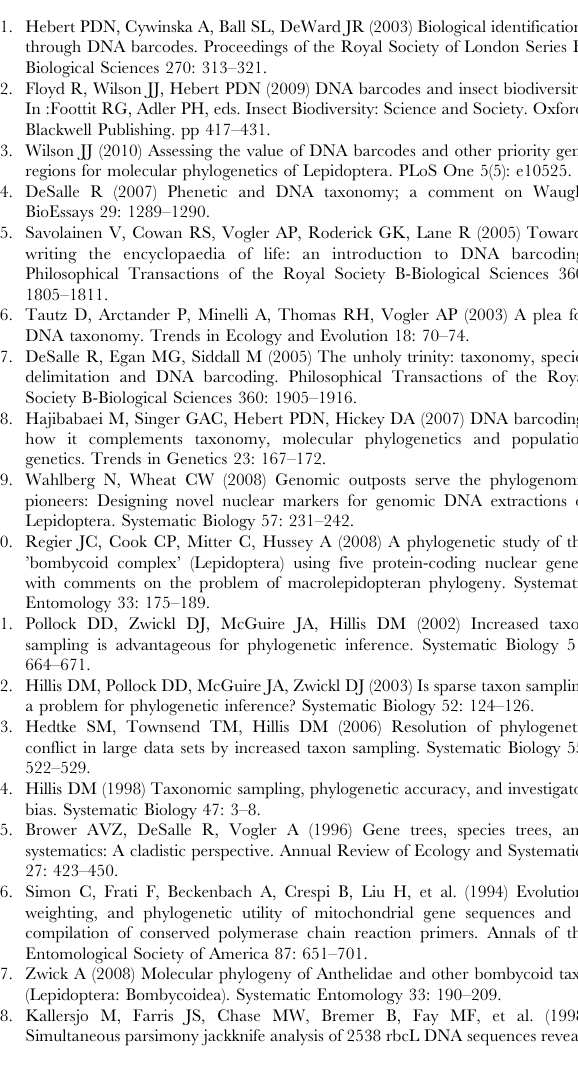
Table S1 Details of the sampling schemes and concor- dance groups used in the study, and the mean p- distances within each concordance group and the entire datamatix for each sample. Table S2 List of taxa used in the